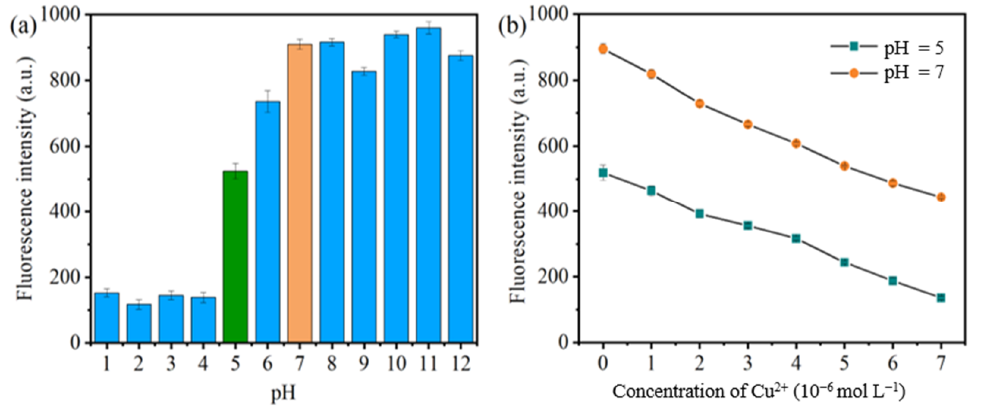
Figure 5. ( a ) Fluorescence intensity of CMC−GE−AQ solution at 579 nm at different pH values. ( b ) Fluorescence intensity of CMC−GE−AQ solution at the pH value 5 and 7 with different Cu 2+ concen- trations. (CMC−GE−AQ: 1.5 × 10 −4 g mL −1 ; solvents: DMF/H 2 O solution ( v / v = 8/2); Cu 2+ : 0~7 × 10 −6 mol L −1 ; excitation wavelength: 425 nm; excitation slit: 5 nm.)